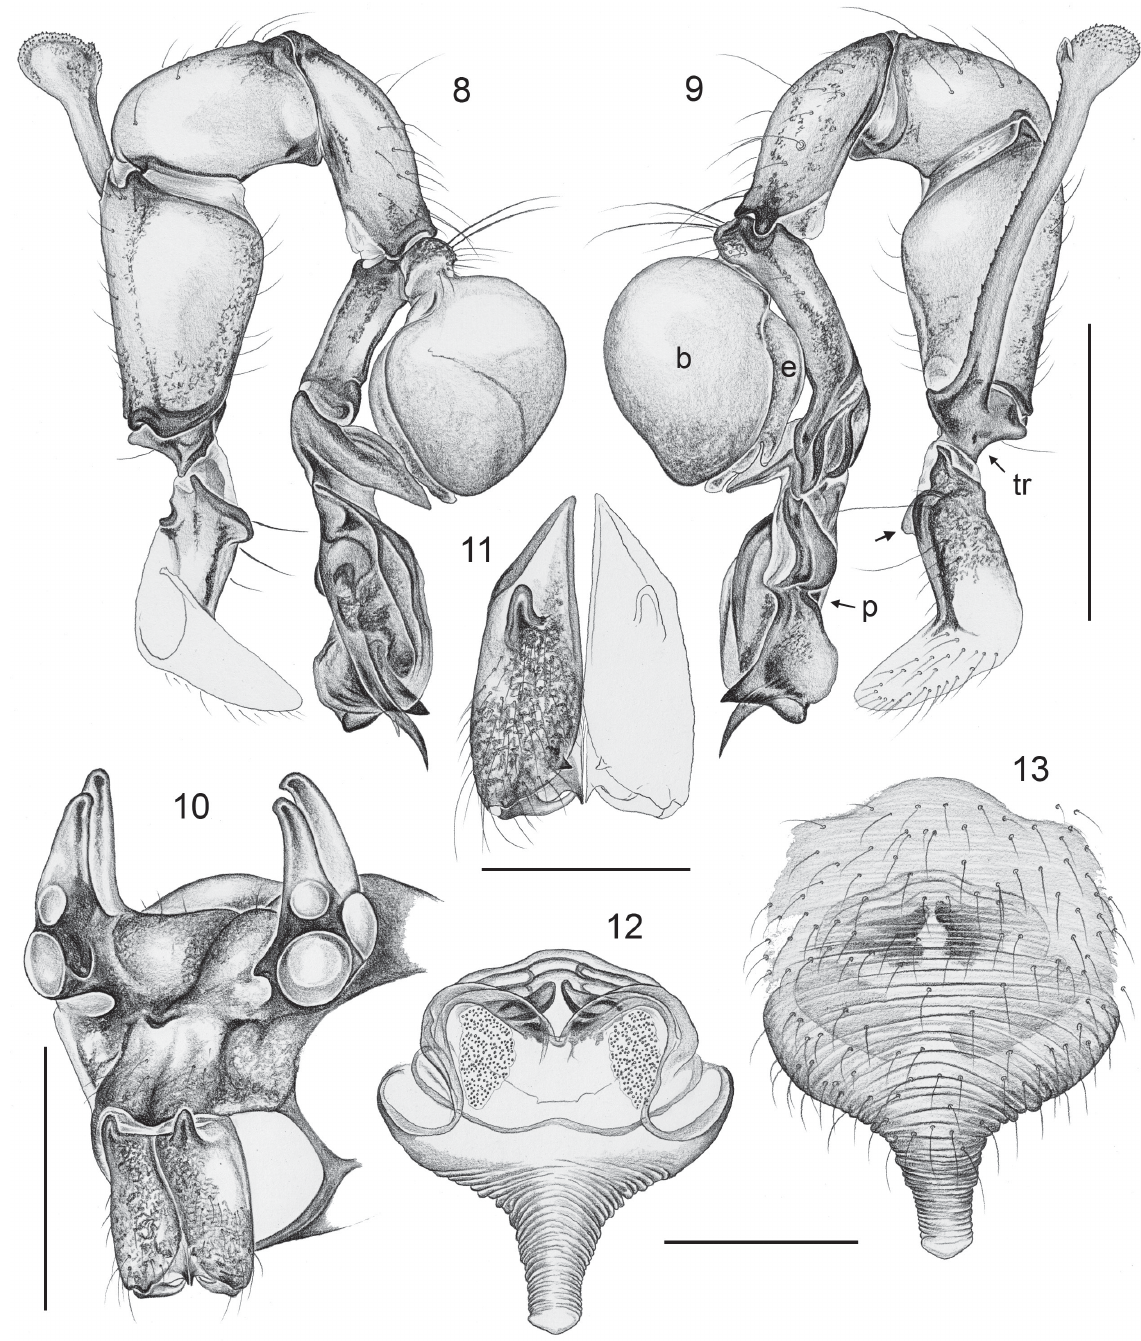
Figs 8–13. Hantu kapit gen. et sp. nov., ZFMK Ar 15069–70. 8–9 . Left male palp, prolateral and retrolateral views (arrow points at ventral process on coxa). 10 . Male prosoma, oblique frontal view. 11 . Male chelicerae, frontal view. 12–13 . Cleared female genitalia, dorsal and ventral views. Abbreviations: b = genital bulb; e = embolus; p = procursus; tr = trochanter. Scale lines: 0.5 mm (8–10); 0.3 mm